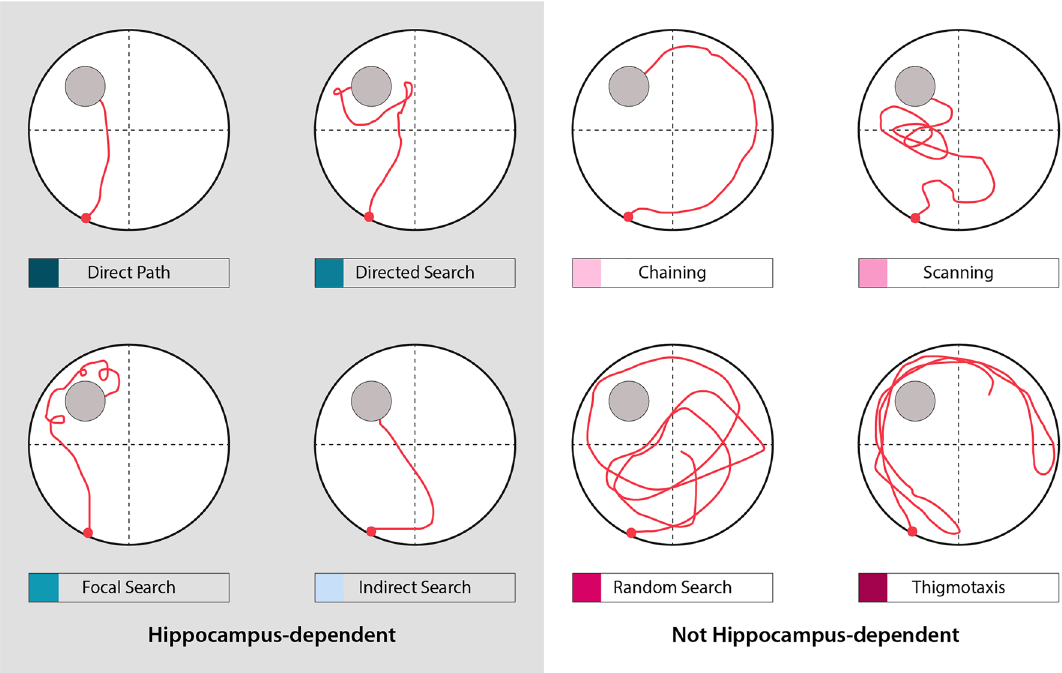
Figure 1. Representative examples of possible search strategies. Search strategies used by mice to locate the hidden platform can be divided into hippocampus-dependent and not hippocampus-dependent strategies. Pathfinder categorizes each trial according to 1 of 8 possible strategies. Spatial strategies include ‘direct path’, ‘directed search’, ‘focal search’ and ‘indirect search’. ‘Chaining’, ‘scanning’, ‘random search’ and ‘thigmotaxis’ are considered as non-spatial